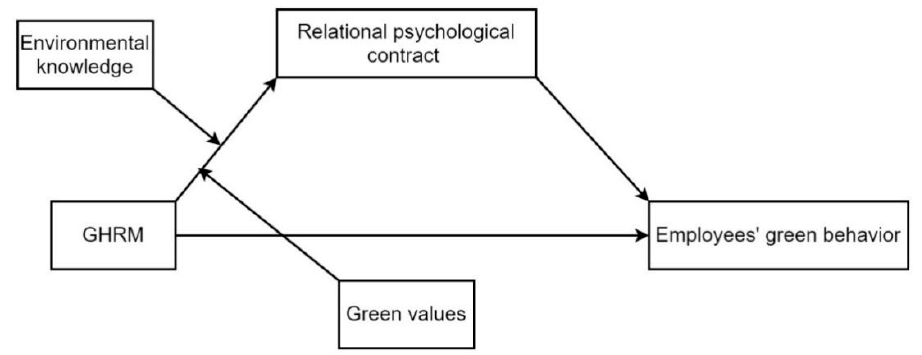
Figure 1. Theoretical research model (a regulated intermediary model).